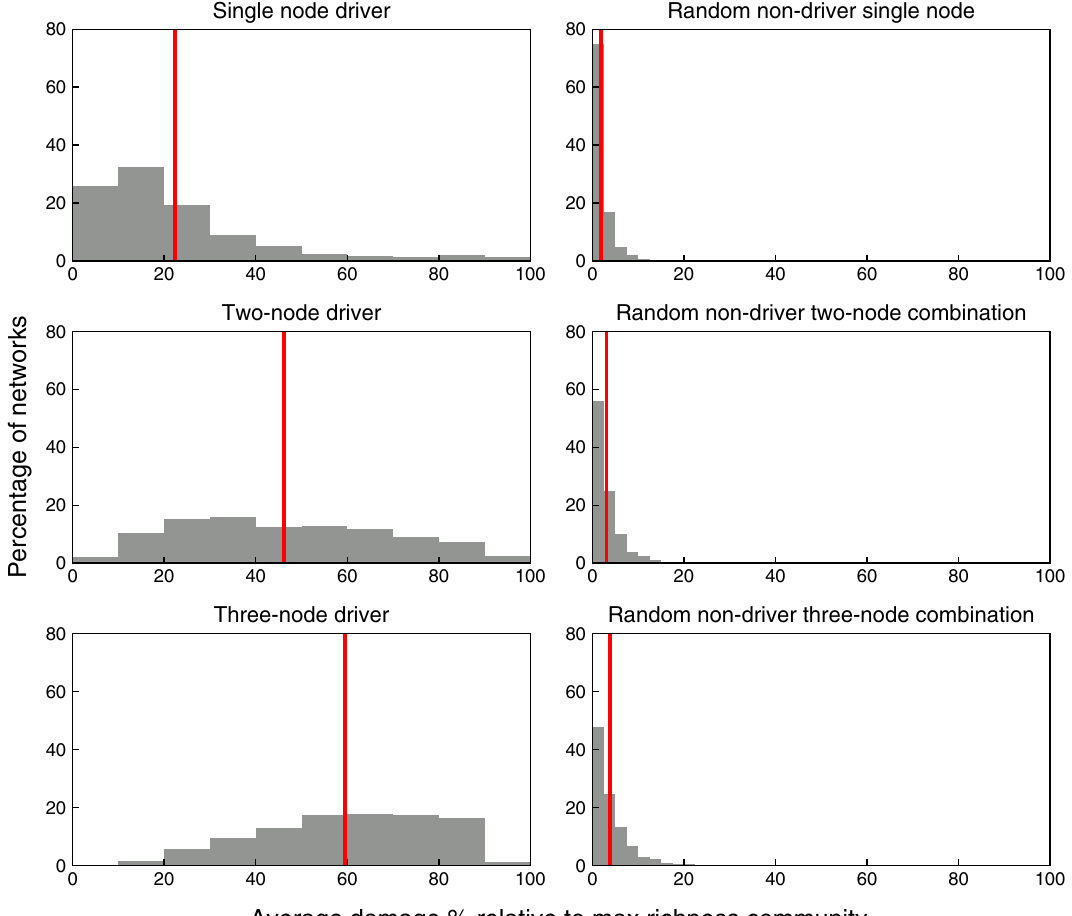
Figure 4. Histogram plots illustrating the average percentage of the damage caused in an established community after the extinction of species. This analysis is performed over 6000 networks with the size of 50–70 nodes. To study the extinction of species we started from the maximal richness community, then we fixed the nodes that correspond to the focal species to the their inactive states. The original extinctions are excluded from the damage percentages. The left column plots show the average damage percentage caused to the maximal richness community by the extinction of a driver set of size 1 (top), 2 (middle), or 3 (bottom) of an inactive stable motif or motif group. For each network, we determined all the relevant driver sets of one stable motif or motif group, we performed the extinction and calculated the resulting damage, then we calculated the average damage percentage over all data points collected for the same network. The right column plots show the average damage percentage caused to the maximal richness community by the extinction of 1 (top), 2 (middle), and 3 (bottom) non-driver, randomly chosen nodes. Each time a randomly selected combination of non-driver nodes were the subject of simultaneous extinction until all combinations are explored and then we calculated the average damage percentage over all data points collected for each network. The number of networks that qualify for each of these 6 categories differ (e.g., some networks have a stable motif with a driver set of size 2 but no stable motif with a driver set of size 3). In the left column 5529, 3212, and 1980 networks and in the right column 5779, 5626, and 5423 networks qualified respectively. The red lines represent the mean value of all the presented data points in each the magnitude of cascading extinctions in the case of extinction of stable motif driver nodes and of nodes with high values of previously introduced structural importance measures. Specifically, we used node betweenness centrality, node contribution to nestedness 47 , and mutualistic species rank (MusRank) 22 to find crucial species based on their structural properties. For more details on definition and adaptation of these two measures see “Methods”. In this analysis, we used each measure to target species in the simplified Boolean models as follows: